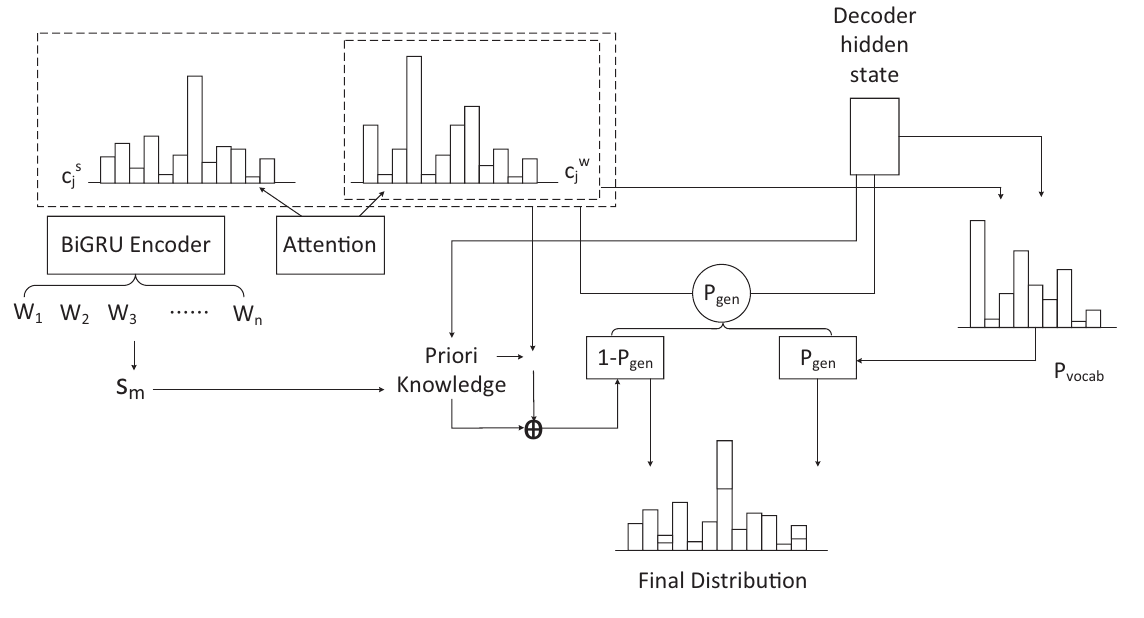
Figure 8. Improved pointer